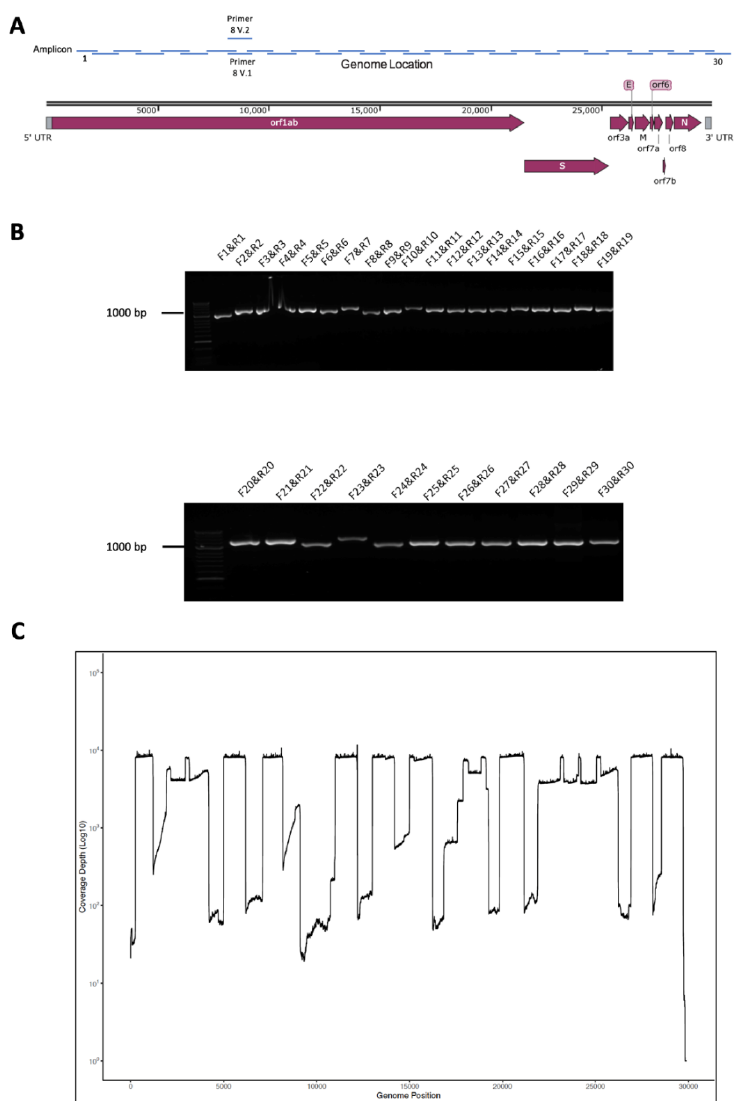
Figure 1. ( A ) Schematic diagram of the severe acute respiratory syndrome coronavirus 2 (SARS-CoV-2) genome showing the position of major open reading frames and the position of the amplicons along the genome. ( B ) Agarose gel electrophoresis analysis of the amplicon products resulting from RT-PCR using the designated forward and reverse primers to amplify the SARS-CoV-2 genome from RNA purified from Vero cells infected with the virus. ( C ) The amplicon products were purified and sequenced on a single flow cell using an Oxford Nanopore MinION. Shown are the number of reads that map ( y -axis) to each amplicon across the SARS-CoV-2 genome from 5 (cid:48) to 3 (cid:48) ( x